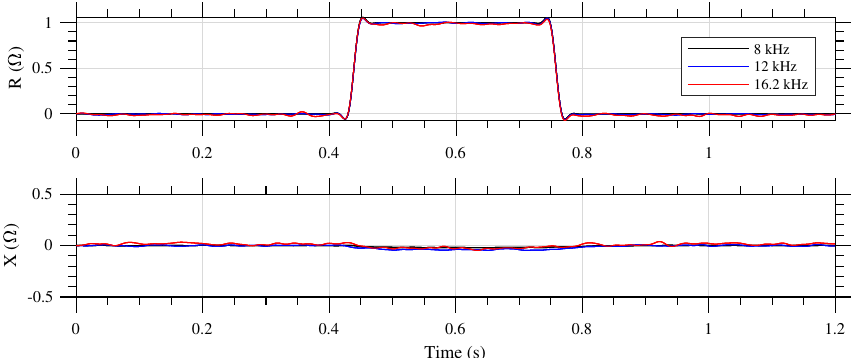
Figure 6. The test-relay system operation validation results for the first standard IL1 sensor